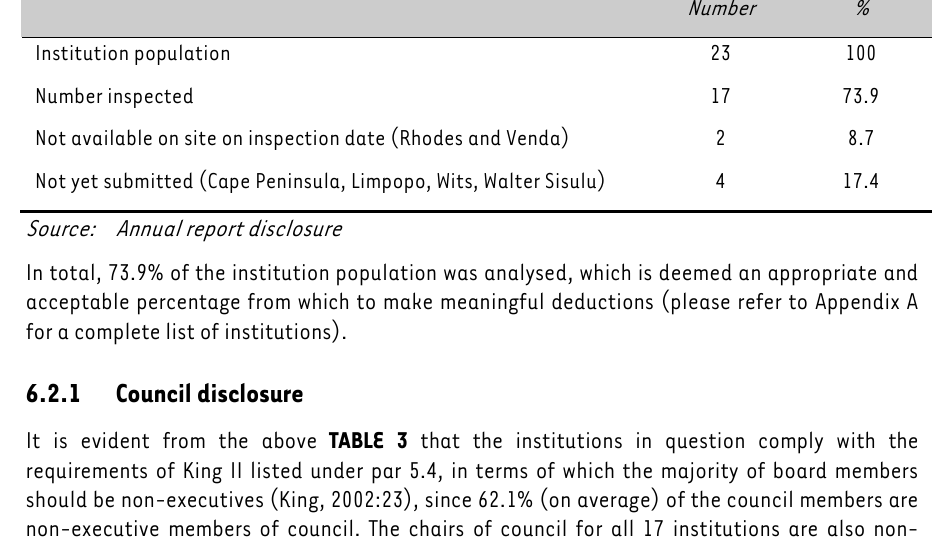
TABLE 2: Analysis of corporate governance disclosures in 2006 annual reports